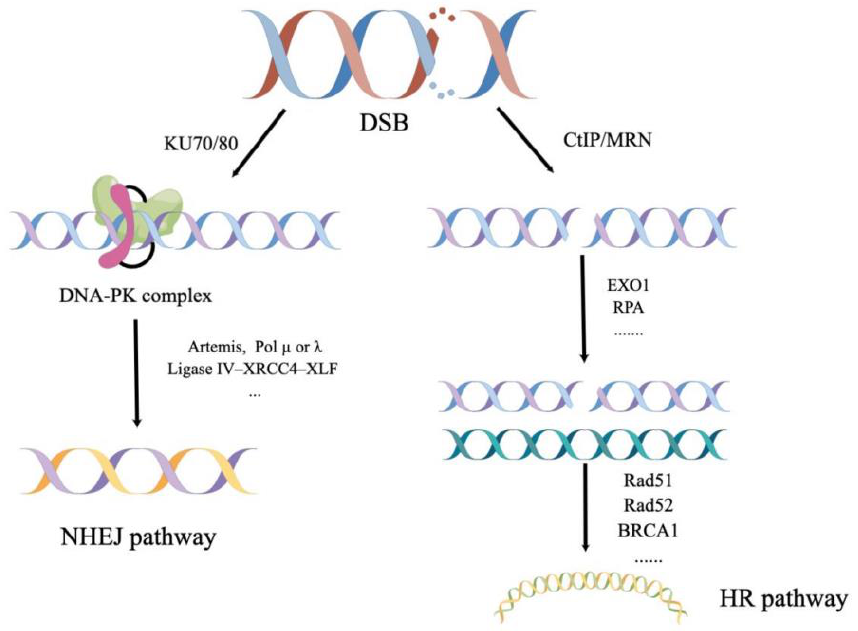
Figure 3. Different pathways of DNA double-strand breaks repair. HR pathway occurs using three steps: extension of ssDNA, a transition from DNA strand invasion to synthesis, and restoration of DNA strand integrity. NHEJ pathway begins with the Ku70/Ku80 heterodimer binding to the ends of the double-strand break (DSB). DNA-PK complex makes this binding even tighter. The ligation step for either strand of the DSB is carried out by the enzymes such as Ligases IV complex shown in the figure. (By Figdraw).